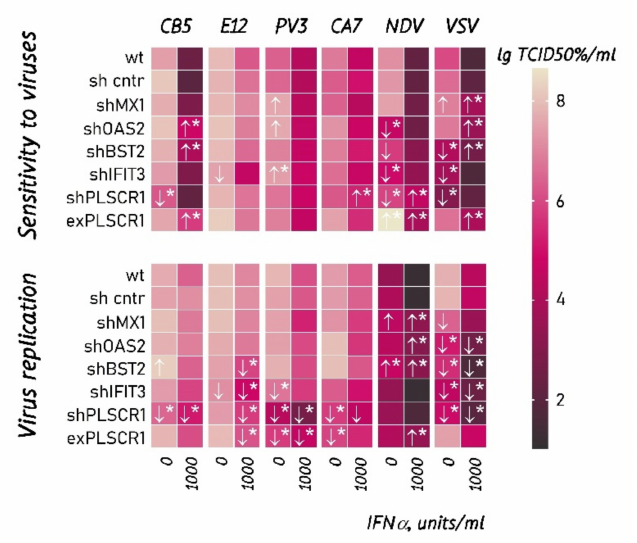
Figure 4. Sensitivity to viruses and virus replication of DBTRG-05MG and their derivatives with overexpression or shRNA-mediated silencing of genes for VSV-I and enteroviruses. The sensitivity and replication were measured in quadruplicates for a range of IFN α concentrations by virus titration in the sensitive RD cells. Cell cultures were treated with IFN α for 24 h, followed by infection with a virus. The tissue culture infectious dose required to reach the fifty percent endpoint, lgTCID50/mL, was measured 24 h after infection. Labels: ↑↓ denote a significant increase or decrease in cell sensitivity/virus replication with t -test p -value < 0.05, * significance corrected for multiple comparisons using the two-stage linear step-up procedure of Benjamini, Krieger, and Yekutieli, Q-value < 0.05 (GraphPad Prism). Abbreviations: VSV, Vesicular stomatitis virus Indiana strain; PV3, Sabin vaccine strain of type 3 poliovirus; NDV, Newcastle disease virus strain H2; CB5, Coxsackie B5 virus strain LEV14; CA7, Coxsackie A7 strain LEV8; E12, Echovirus 12 strain